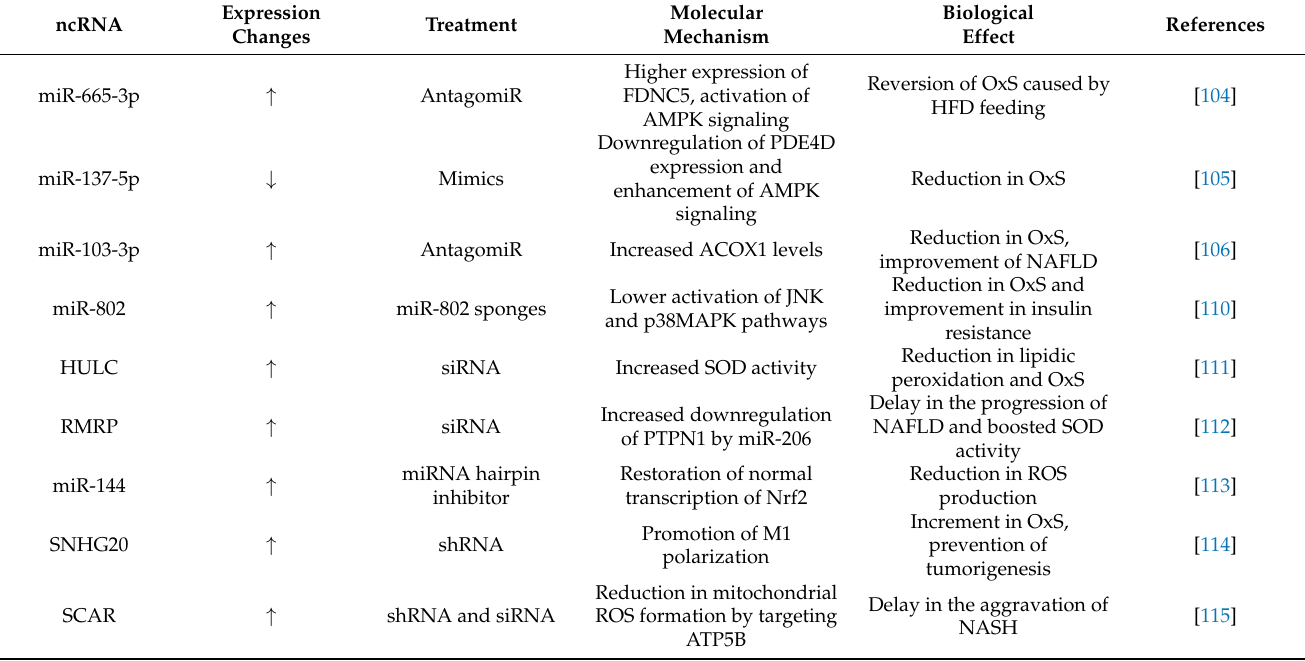
Table 2. Overview of ncRNA-based therapies for the assessment of NAFLD. ↑ up regulation, ↓ down